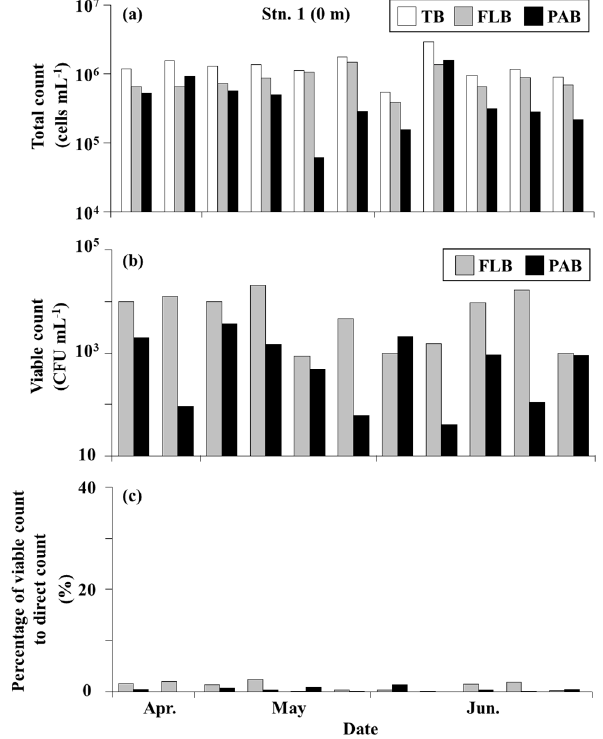
Figure 6. Bacterial numbers in the seawater samples from Stn. 1 (0 m): the direct counts ( a ), the viable counts (CFU) ( b ), and the percentages of viable counts to direct counts ( c ).